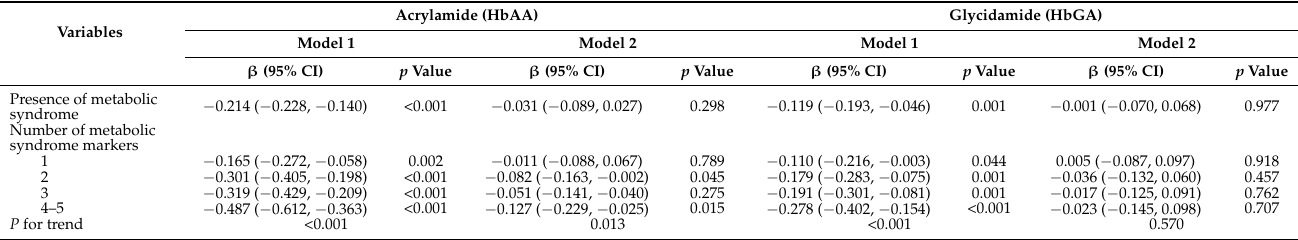
Table 3. Regression coefficients of the presence and number of metabolic syndrome components with log-transformed hemoglobin-adducted acrylamide (HbAA) and hemoglobin-adducted glycidamide (HbGA) concentration. Acrylamide (HbAA) Variables Presence of metabolic